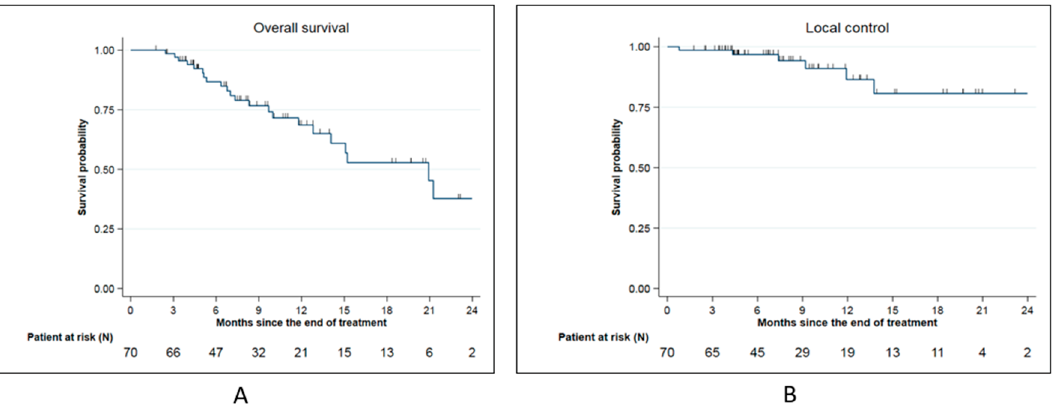
Figure 2. Survival date for the whole cohort: ( A ): Overall survival for the whole cohort; ( B ): Local control for the whole cohort.